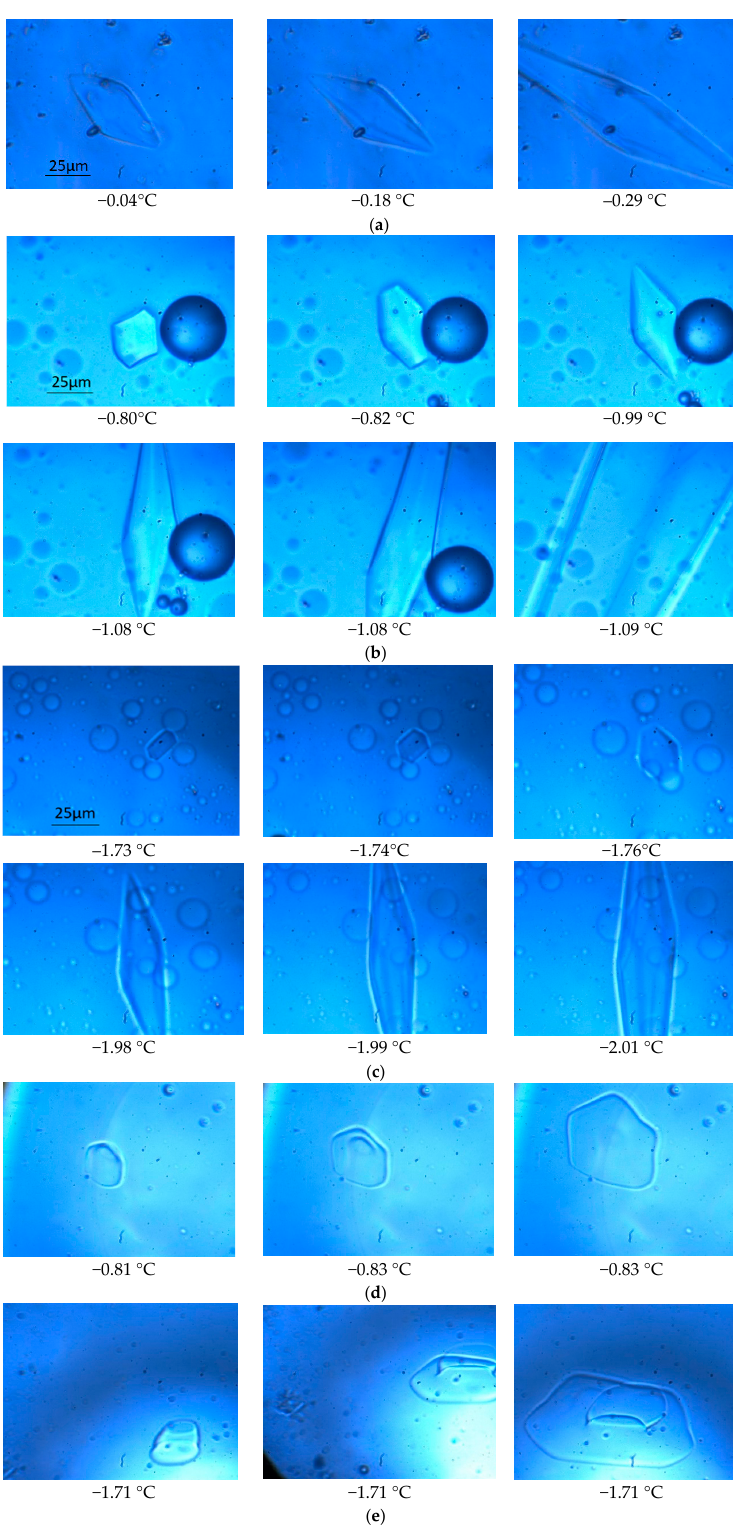
Figure 1. Cryo-photo microscopic images of ice crystals confined by 2.0 mg/ml spin-labeled L23C in ( a ) water; ( b ) 5% glycerol solution, and ( c ) 5% propylene glycol solution, and ( d ) and ( e ) cryo-photo microscopic images of ice crystals grown in the 2.0 mg/ml spin labeled A17C in the 5% glycerol solution, and 5% propylene glycol solution, respectively. (The differences in hue were caused by different filters used when the images were taken, and the bubbles were caused by the dissolved air in the solutions.)